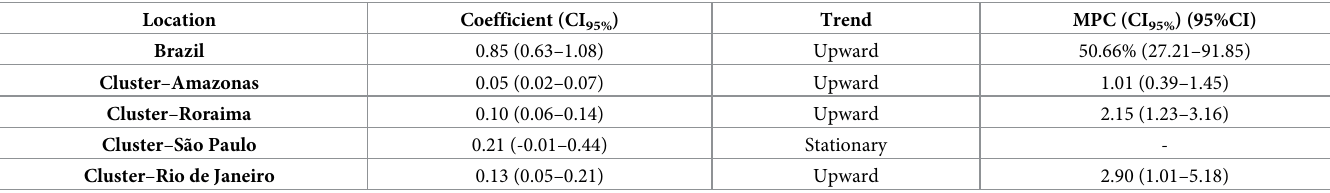
Table 2. Tuberculosis temporal trend in migrants in Brazil and in clusters identified by Getis-Ord Gi � analysis, Brazil (2014–2019).